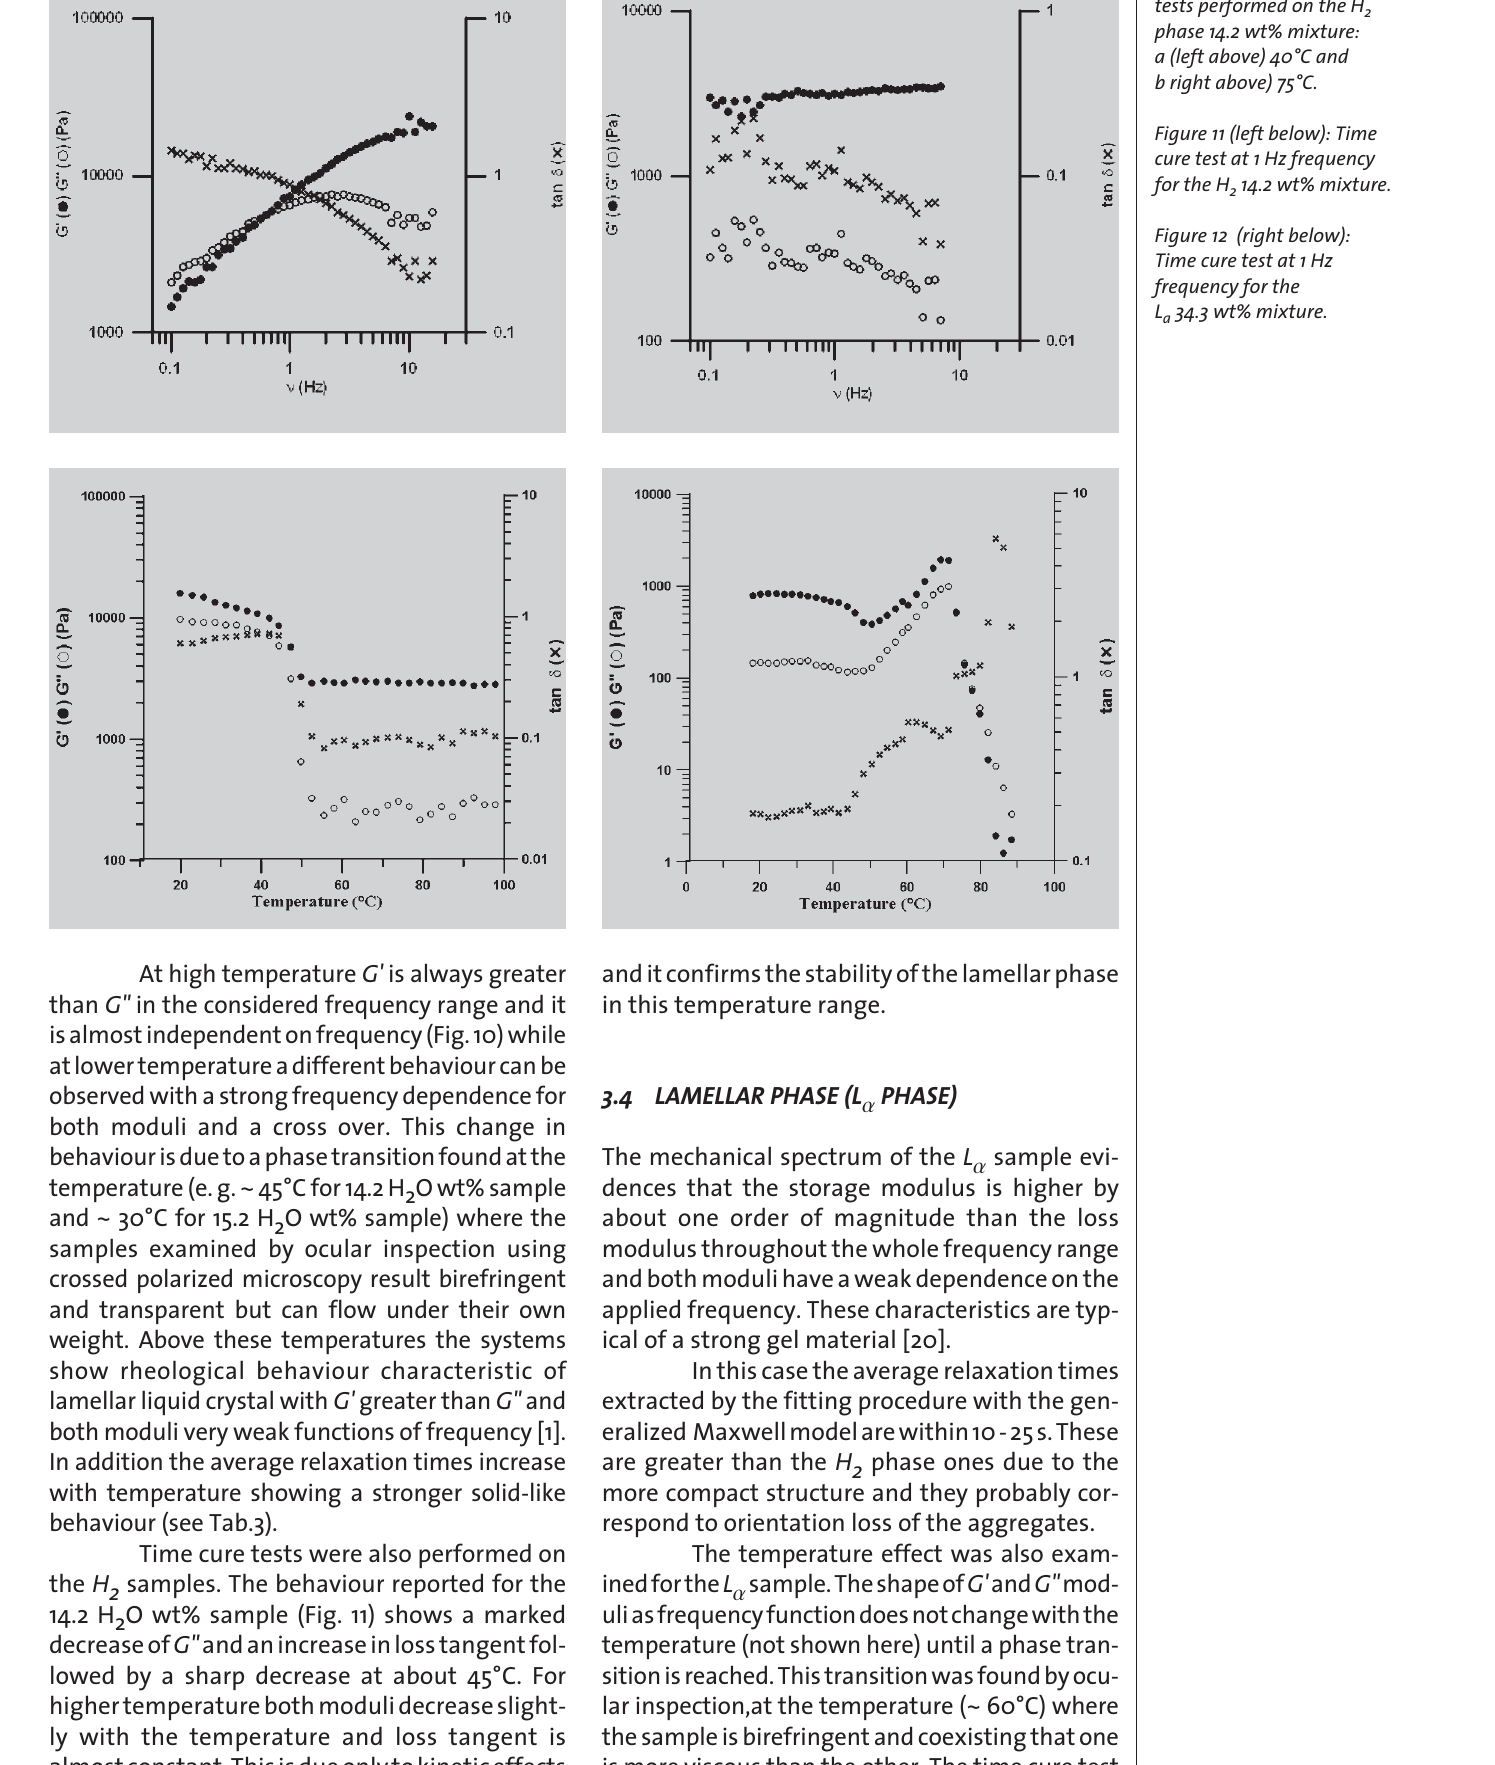
Figure 10: Frequency sweep tests performed on the H 2 phase 14.2 wt% mixture: a (left above) 40°C and b right above) 75°C. Figure 11 (left below): Time cure test at 1 Hz frequency for the H 2 14.2 wt% mixture. Figure 12 (right below): Time cure test at 1 Hz frequency for the L a 34.3 wt%